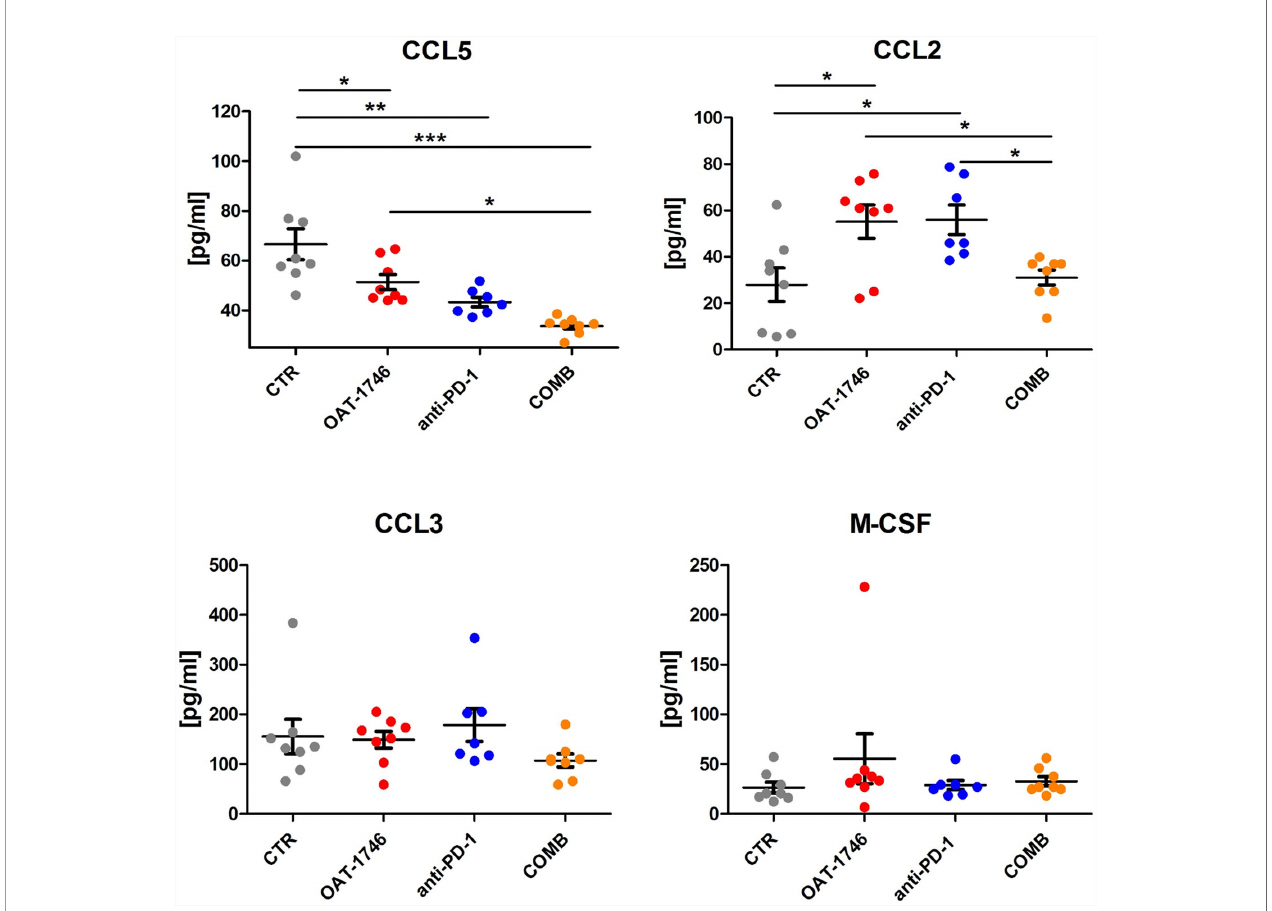
FIGURE 5 | The effect of treatment on the levels of pro- and anti-in fl ammatory cytokines. The levels of pro/anti-in fl ammatory cytokines were determined in blood plasma of the animals from the experimental groups described above using a multiplexed bead-based assay and Luminex technology (MAGPIX). Histograms show the levels of tested cytokines in pg/mL; the results are shown as means ± SEM; signi fi cance was assessed with One – Way ANOVA and Bonferroni ’ s multiple comparison test, ***p < 0.001; **p < 0.01; *p <